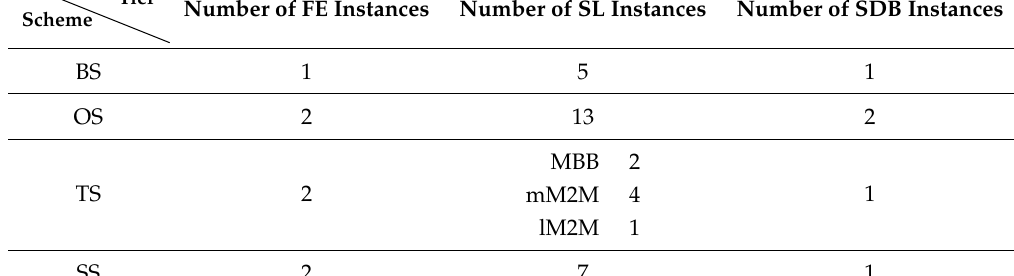
Table 7. vMME model dimensioning at the simulation point.